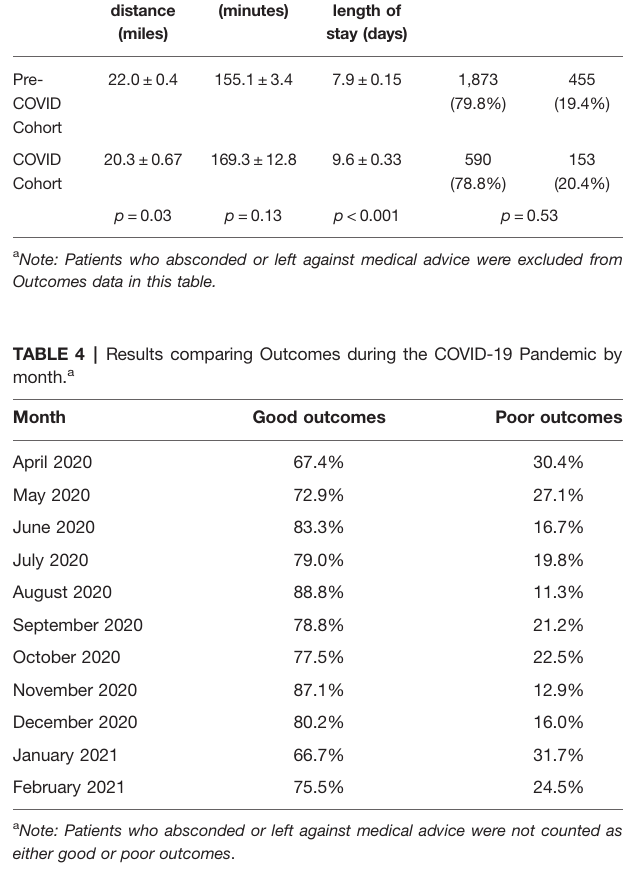
TABLE 3 | Results comparing Mean Transfer Distance, Mean Inpatient Length of Stay, and Outcomes between the two cohorts. a Mean transfer